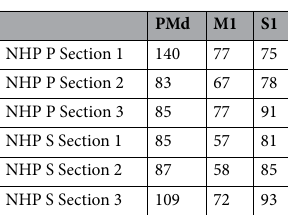
Table 2. Number of Units for each recorded region for the two